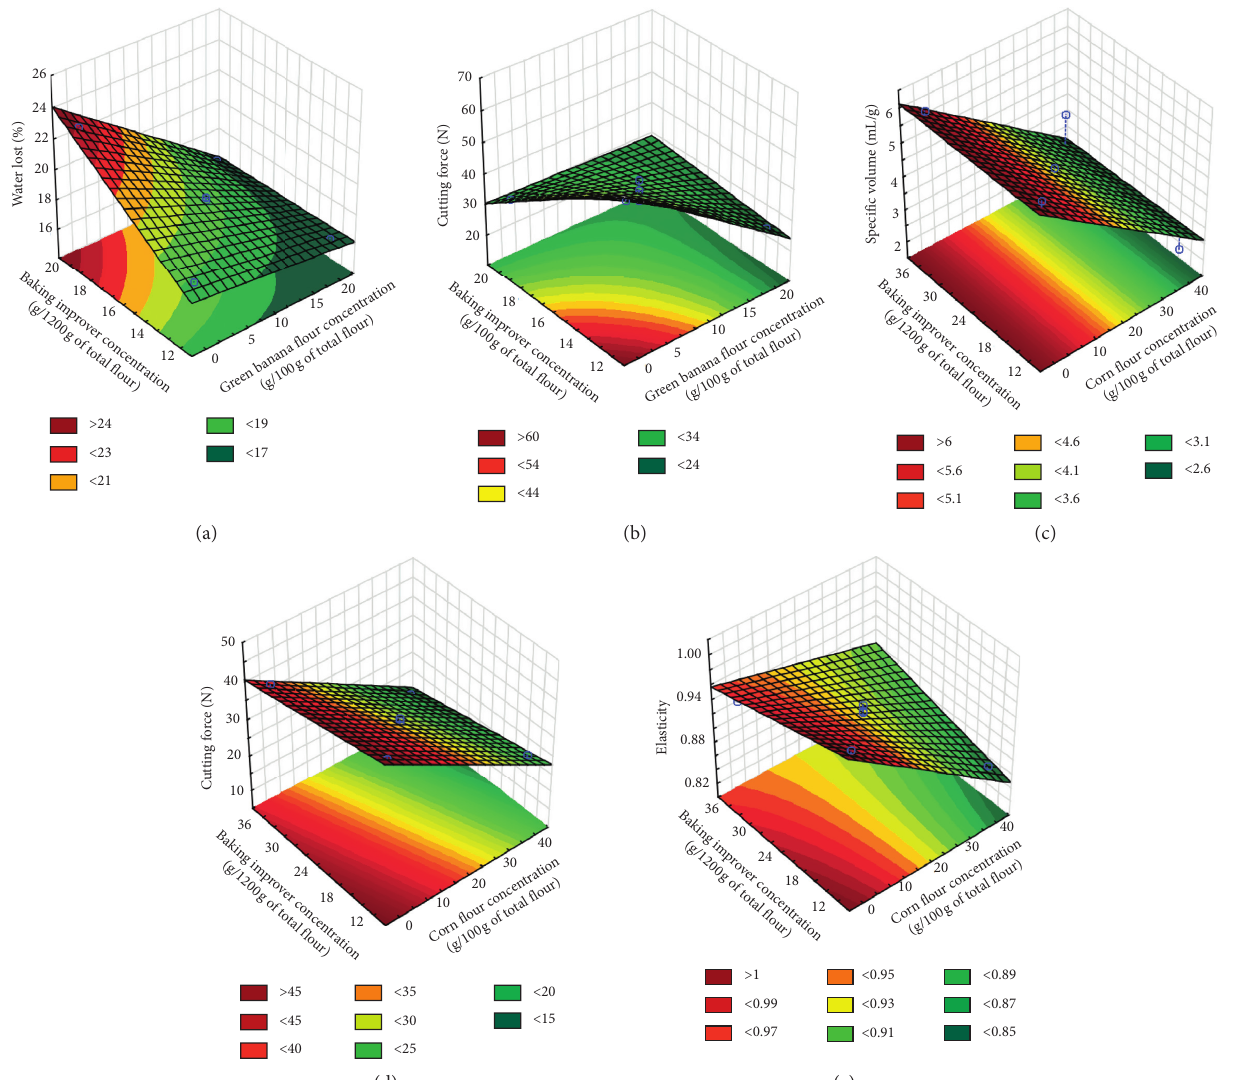
Figure 1: Response-surfaces for water loss (WL) (a) and cutting force (CutF) (b) effect of green banana flour concentration ( C baking improver concentration ( C BI ) and response-surfaces for specific volume (SV) (c), CutF (d), and elasticity (El) (e) effect of corn flour concentration ( C CF ) and baking improver concentration ( C BI